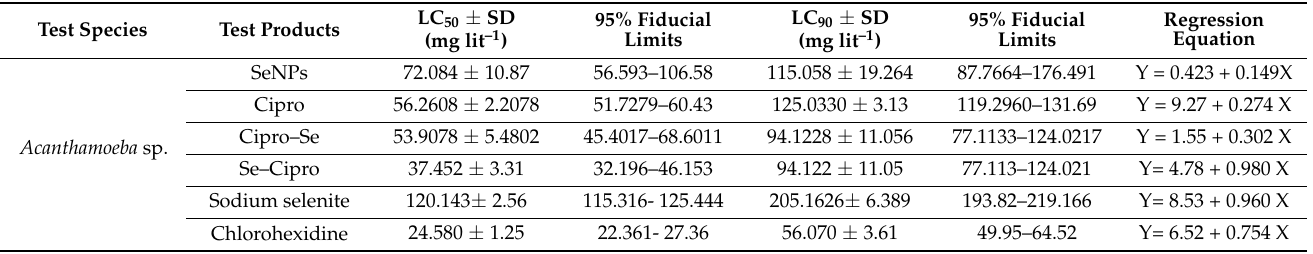
Table 1. Anti- Acanthamoeba activity of nano-selenium (Se), ciprofloxacin, and their conjugate.